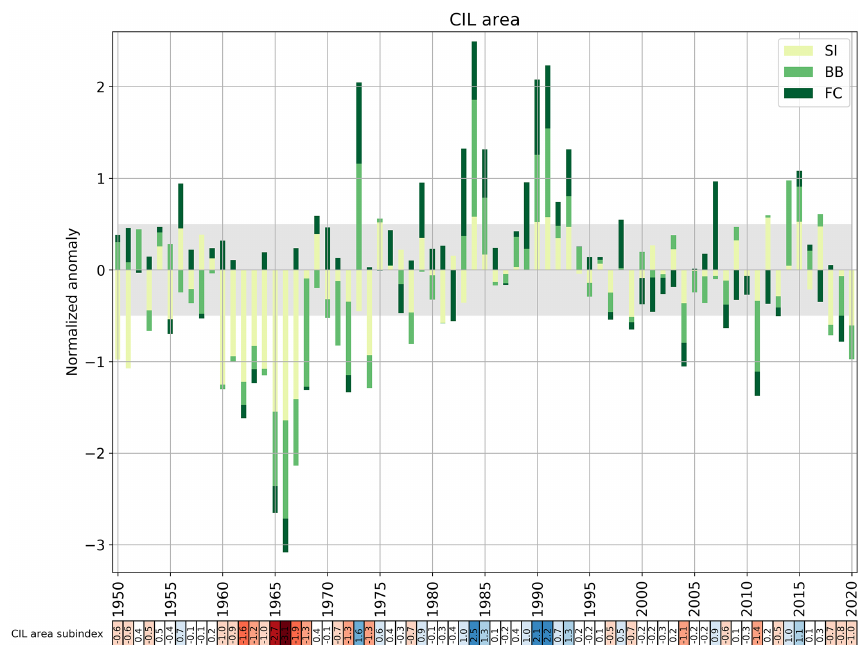
Figure 10. Normalized anomalies of the mean CIL area for hydrographic sections Seal Island (SI), Bonavista Bay (BB) and Flemish Cap (FC). This time series correspond to the average of the three sections, in which the contribution of each section is represented. The shaded area corresponds to the 1991–2020 average ± 0 . 5SD. The numerical values of this time series are reported in a colour-coded scorecard at the bottom of the figure. Here negative anomalies (generally corresponding to warmer conditions) are coloured red and positive anomalies blue. This time series is one component of the NL climate index.